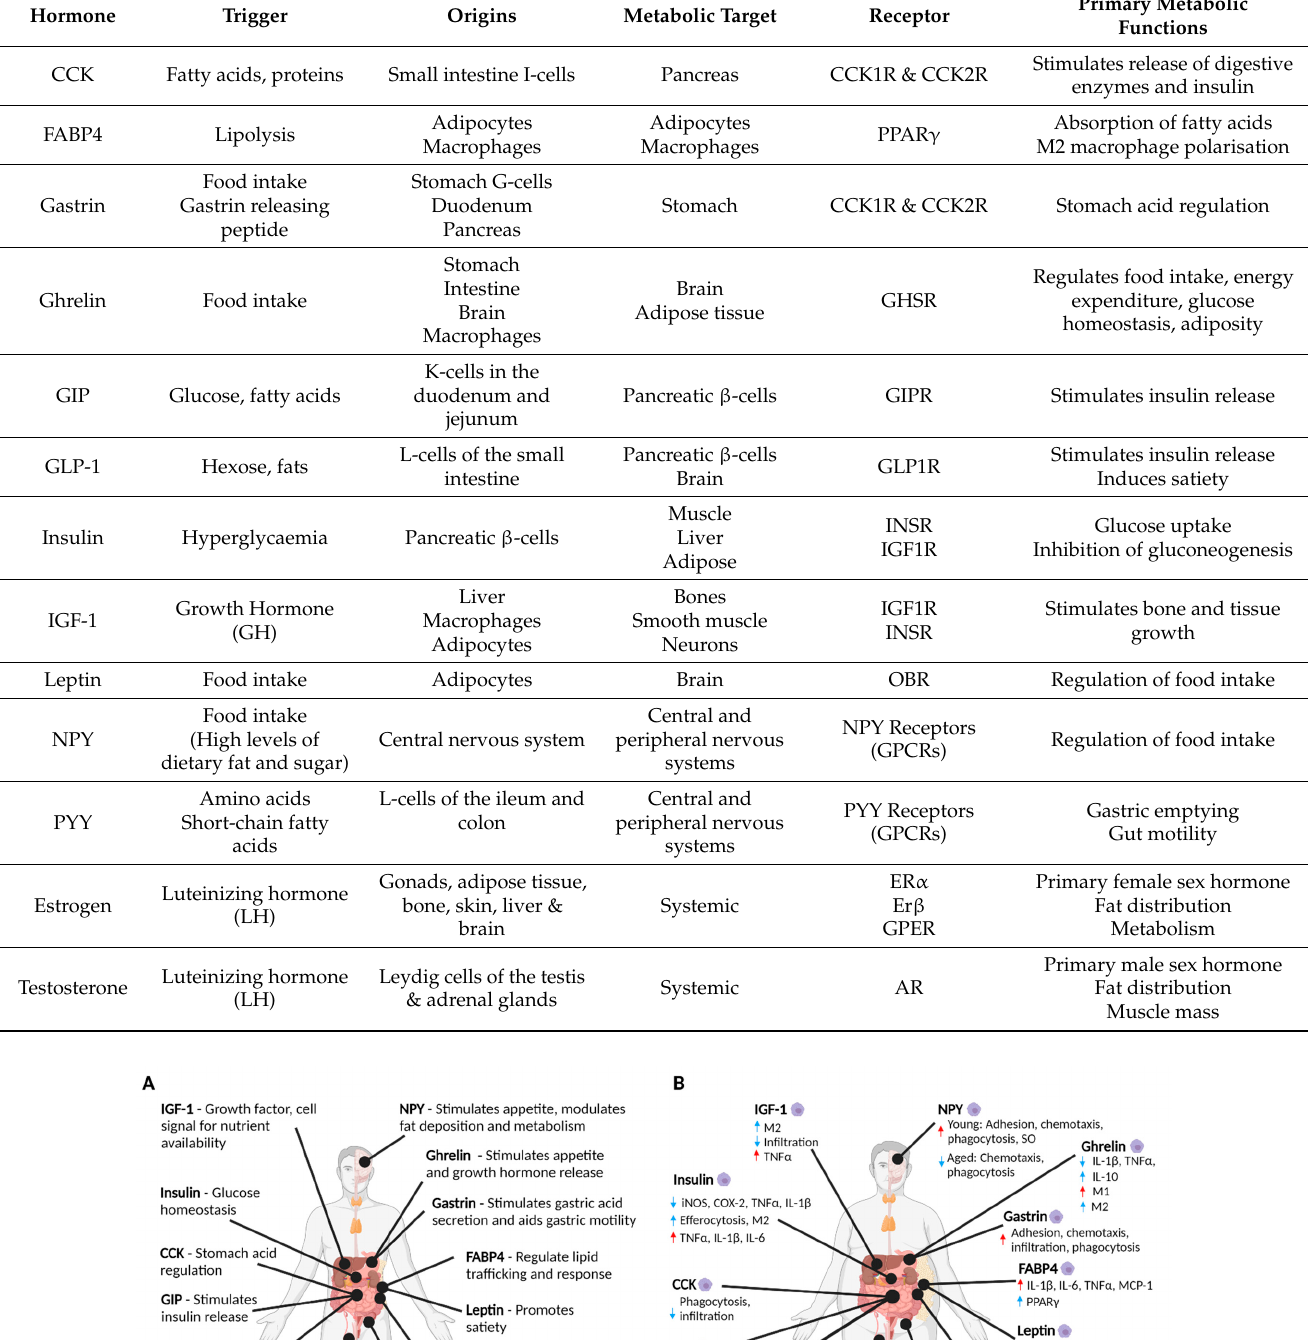
Table 1. Summary of the metabolic hormones reviewed.